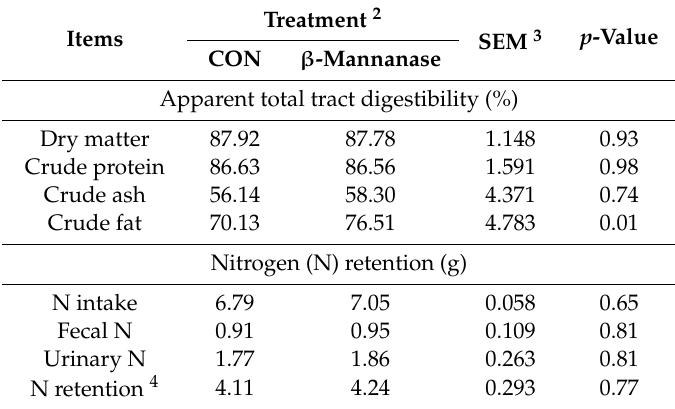
Table 3. E ff ects of dietary supplementation of β -mannanase on apparent total tract digestibility and nitrogen retention in weaning pigs 1